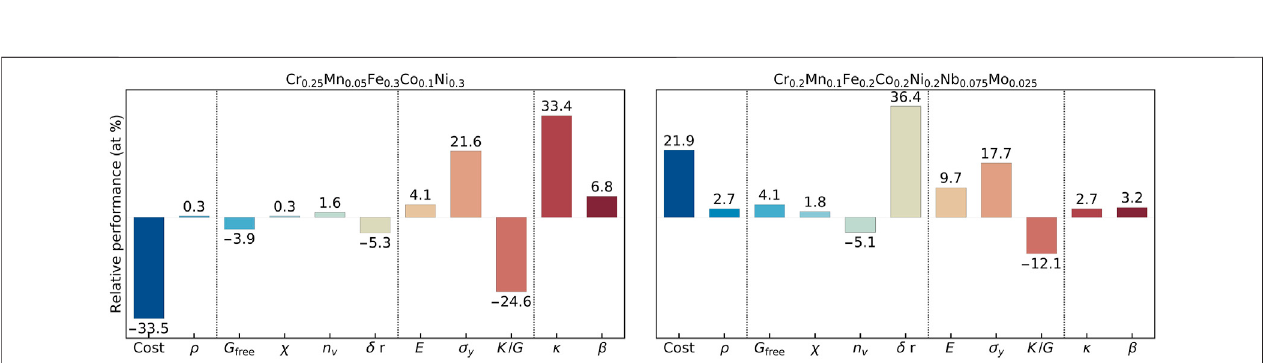
FIGURE 8 | Optimized candidate compositions for fi ve- and seven-principal-elements high-entropy alloys for effective heat sinks, operating at high temperatures. The Wendland radial basis functions are used for interpolating the compositional spaces.